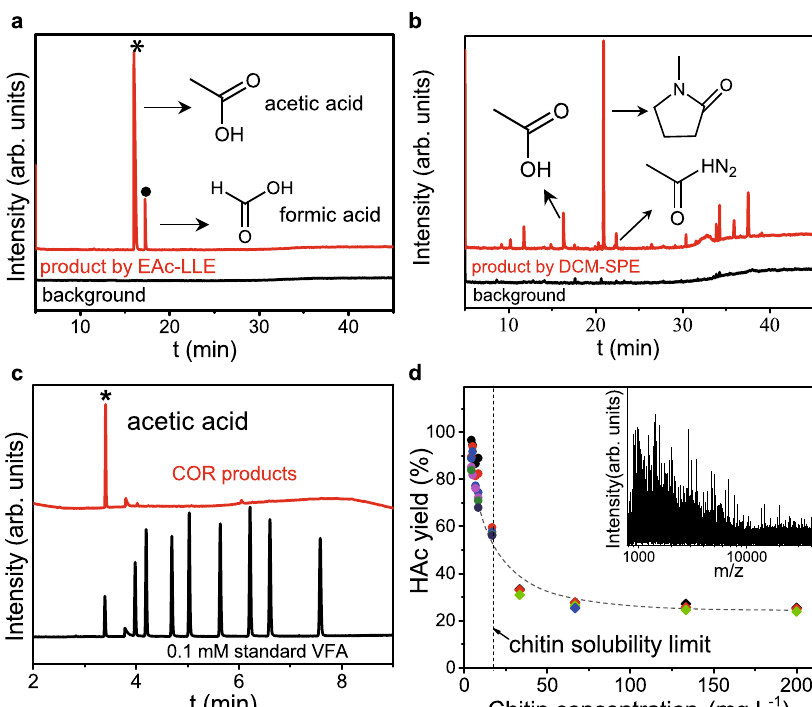
Fig. 4 Identi fi cation and quanti fi cation of products. Gas chromatography-mass spectrum (GC-MS) analysis of anodic reaction products after a , liquid – liquid extraction (LLE) and b solid-phase extraction (SPE). The black curves in ( a ) and ( b ) are spectra of background. The corresponding chemicals associated with the main peaks are labeled. c GC-FID quanti fi cation of acetic acid. The spectrum of the standard VFAs sample (black spectrum) is shown for comparison. d Yield curve of acetic acid. The vertical dotted line labels the chitin solubility limit using freeze-thawing pretreatment. Inset: MALDI-TOF mass spectra of freeze-thawing dissolved chitin in 1.0 M KOH solution. Each data point represents an individual